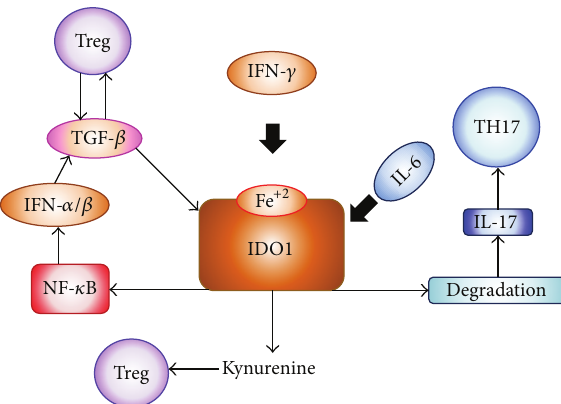
Figure 3: IDO1 induction and proinflammatory cytokines. IFN- 𝛾 drives intense enzymatic IDO1 activity, resulting in TRP depletion and high-level production of immunoregulatory TRP metabolites, KYNs, which may foster Tregs expansion. Induced Tregs use TGF- 𝛽 to maintain an IDO1-dependent regulatory environment, with IDO1 mostly functioning as a signaling molecule. Both mechanisms are interrupted by IL-6, which drives IDO1 degradation as potent inflammatory stimuli enter the local environment